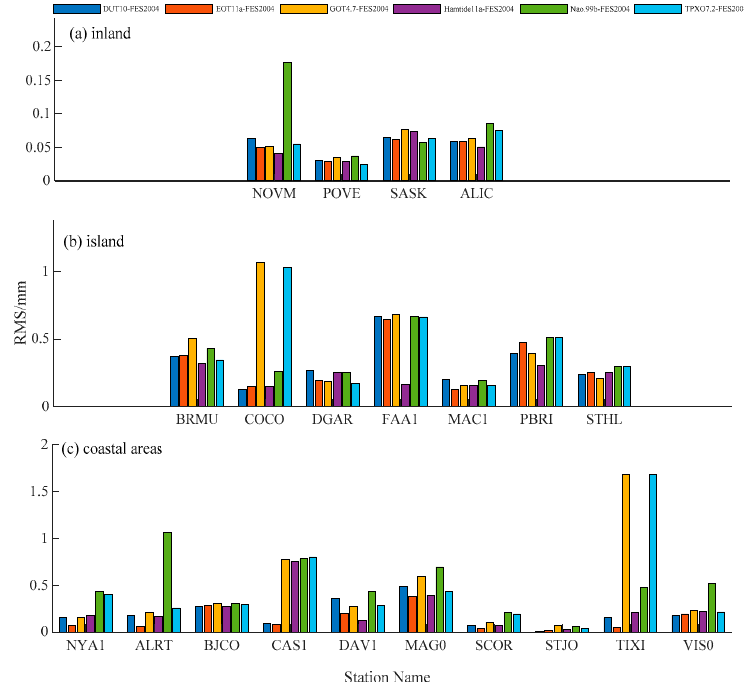
Figure 10. The RMS error of differences between ZTDs calculated using the FES2004 ocean tide model (as reference) and the other OTL models at ( a ) inland, ( b ) island and ( c ) coastal areas.